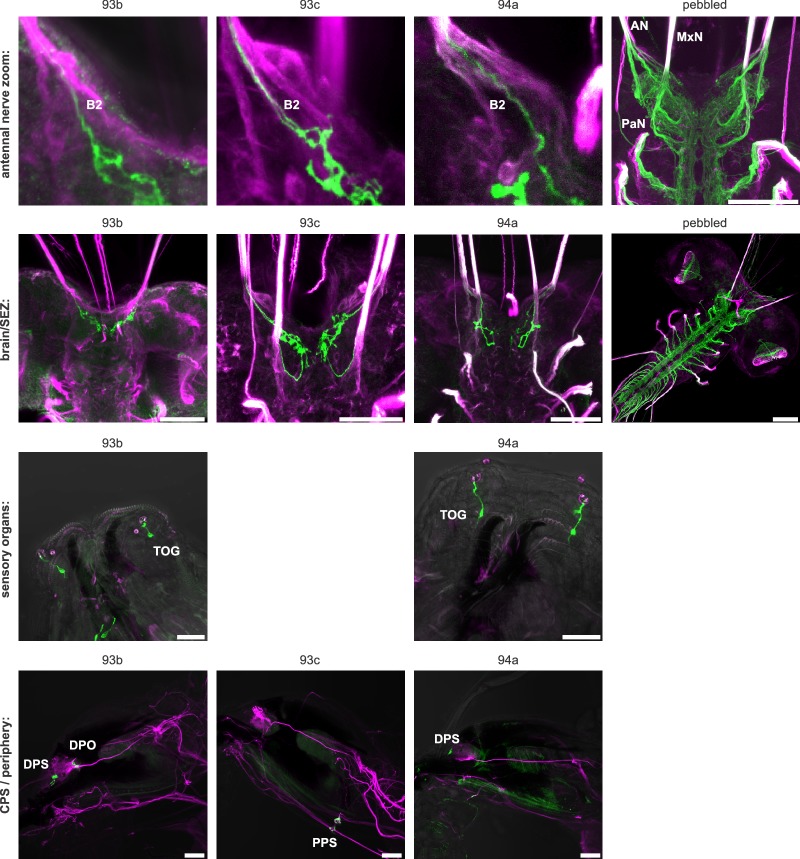
Gustatory receptor expression.Top row scale and all scale bars = 50 µm.